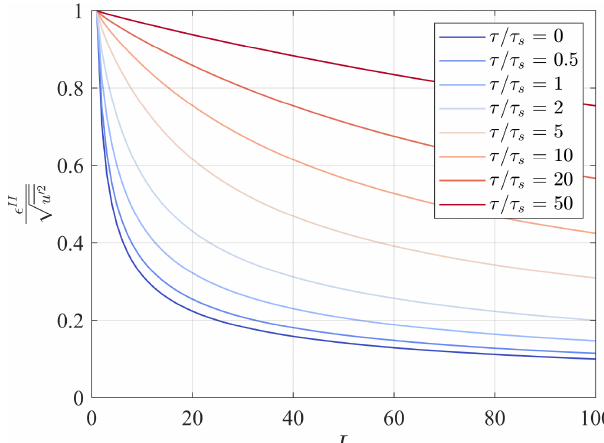
Figure 6. Standard deviation of the sample mean normalized by the standard deviation of velocity as a function of the number of real- izations, L , and for different values of the ratio between the integral timescale and the sampling time, τ/τ s